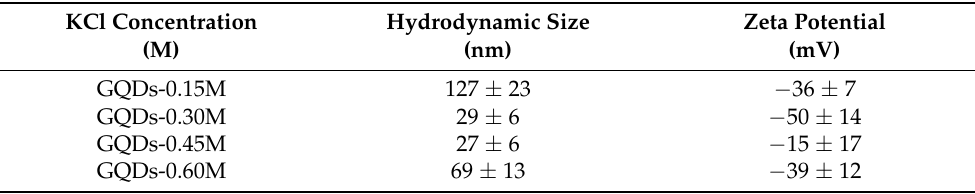
Table 1. Comparison of hydrodynamic size and zeta potential at various KCl concentrations.